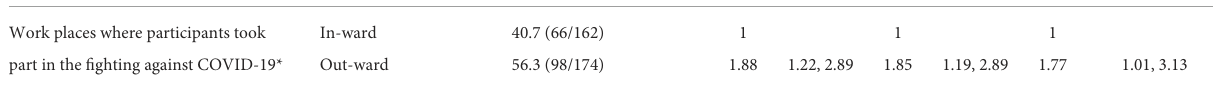
a Model1:uni-variatelogisticregressionanalysiswithworkmodeastheindependentvariable. b Model2:multi-variatelogisticregressionanalysis,withadjustmentforparticipants’age,genderandeducationallevel. c Model:multi-variatelogisticregressionanalysis,withconsiderationofprofessionaltitle,occupation,yearsofprofessionalemployment,dailytimewithprotectivesuit,continuousworking daysofinvolvementinfightingagainstNanjingCOVID-19epidemic,nightshift,historyofNCDsinadditiontothoseadjustedforinModel2. *